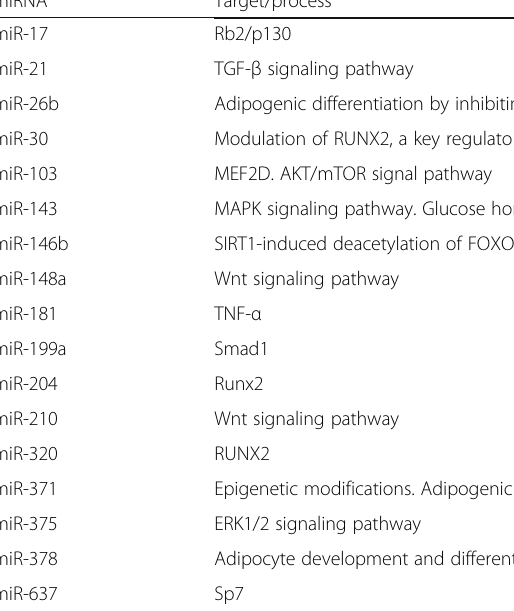
Table 2 Adipogenesis promoting miRNAs miRNA